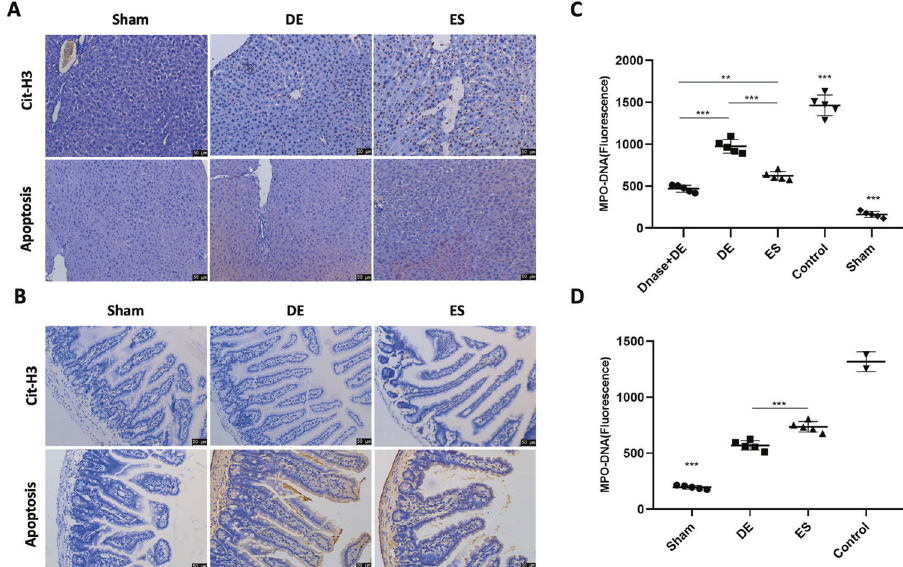
Fig. 4 De-escalation antibiotic therapy modulated the formation of NETs during sepsis. A , B The liver and intestine tissues collected in each group were treated with the IHC examination. Severer liver and intestine injuries were correlative to more positive citH3 and apoptotic cells in these tissues. The de-escalation group had milder liver and intestine injuries and lower NETs than the escalation group. C At the early stage of sepsis (Day 3), blood was drawn from different groups ( n = 25), and serum MPO-DNA levels were determined with a mouse MPO ELISA kit. DE group showed higher serum MPO-DNA levels than the ES group, and both were lower than the control group ( p < 0.001). Higher MPO-DNA levels were diminished with the administration of DNase I ( p < 0.001). D At the late stage of sepsis (Day 6), serum MPO-DNA levels were determined the same way ( n = 20). The ES group showed higher levels of serum MPO-DNA than the DE group ( p < 0.01), and both were higher than the sham group ( p < 0.001). DE de-escalation. ES